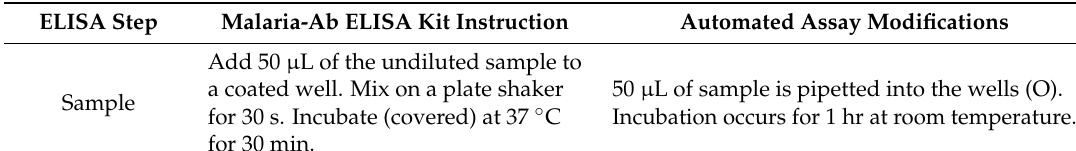
Table 1. Malaria-Ab Enzyme-linked Immunosorbant Assay (ELISA) instructions as provided by the kit manufacturer and modified steps executed by the automated bioassay